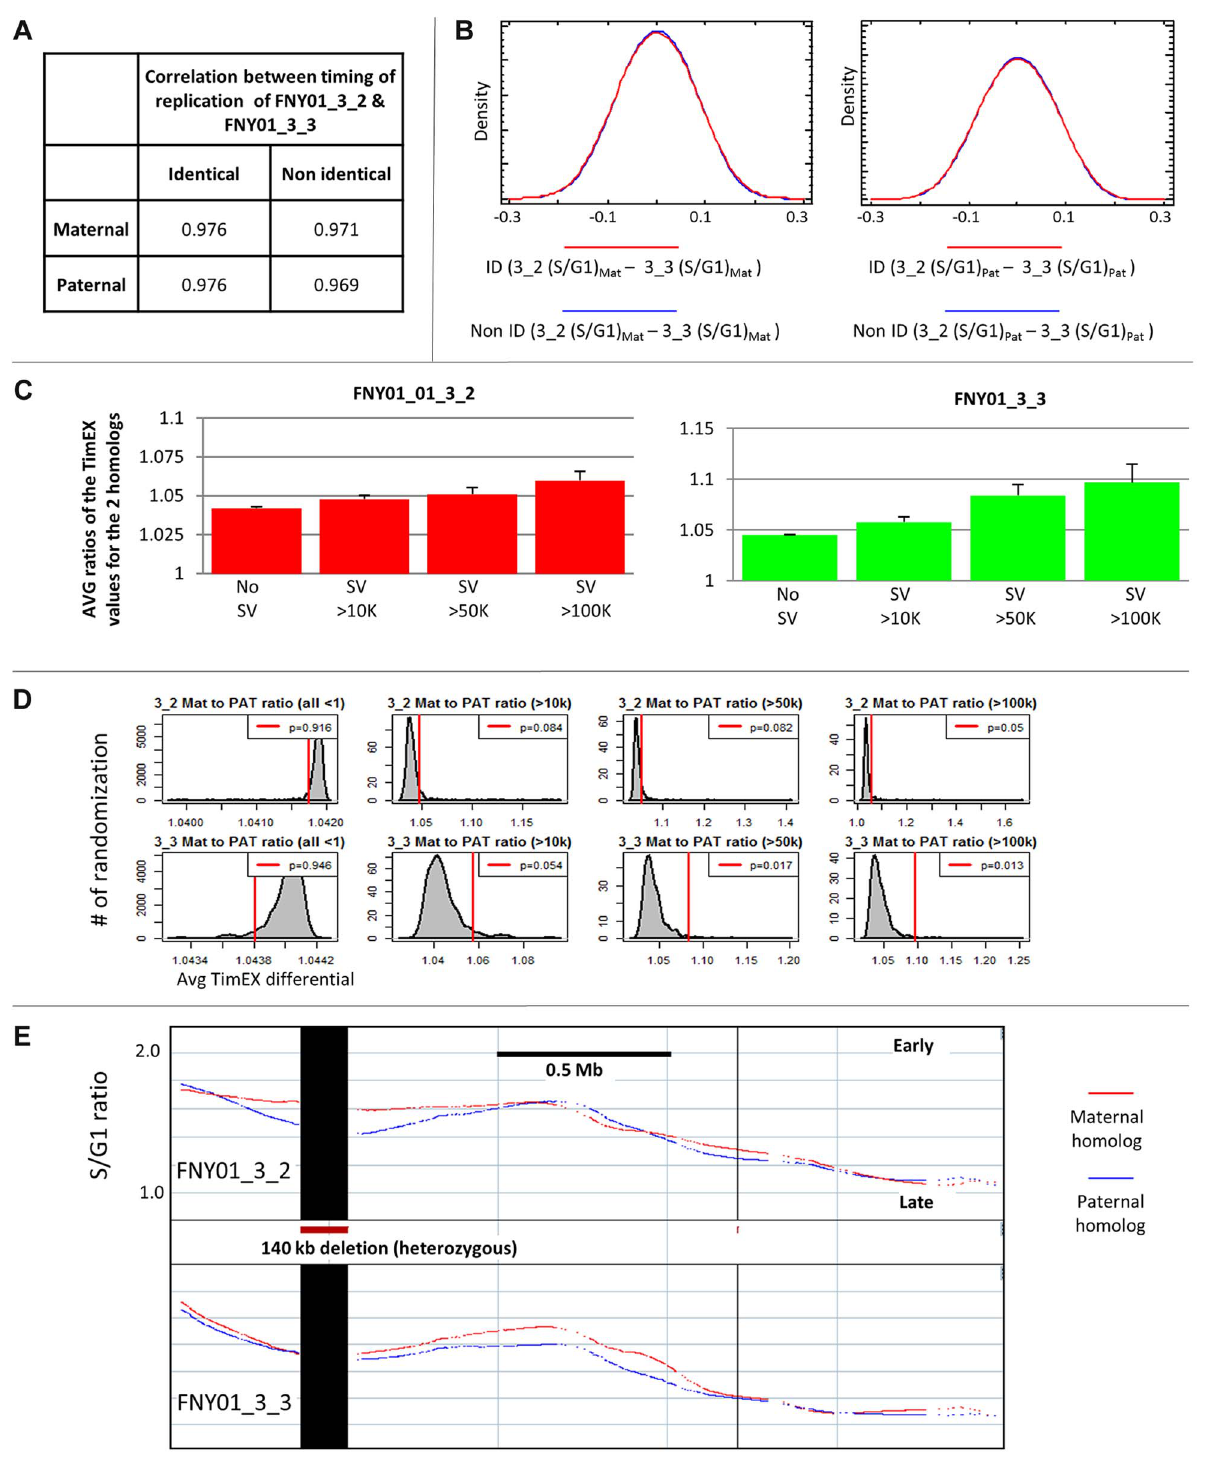
Figure 2. Presence of large structural variants can alter replication timing regionally. A: Comparison of the timing of replication in genetically identical and non-identical regions. Coefficients of correlation between the timing of replication of the two maternally inherited or the two paternally inherited chromosomes calculated in 500 bp windows in the identical and non-identical regions of the genome of FNY01 3_2 and 3_3. The timing of replication is very similar in the identical and non-identical regions. B: left panel: Density traces of the differences between the mean- centered TimEX values of the maternal homologs in individuals FNY01_3_2 and 3_3 in the identical (ID) and non-identical (Non ID) regions. Differences were calculated in 500 bp windows. The timing of replication of the maternally inherited chromosomes of FNY01 3_2 and 3_3 are as closely related to each other is the non-identical and identical regions. Right panel: same but for the paternal homologs. C: Histograms illustrating the mean ( 6 S.E.M) of the avg timing of replication differential of the paternal and maternal homologs in 500 kb intervals containing either no SVs greater than 10 Kb (No SVs), or SVs larger than 10, 50 and 100 kb for individual FNY01_3_2. For each 500 kb interval, the timing differential was